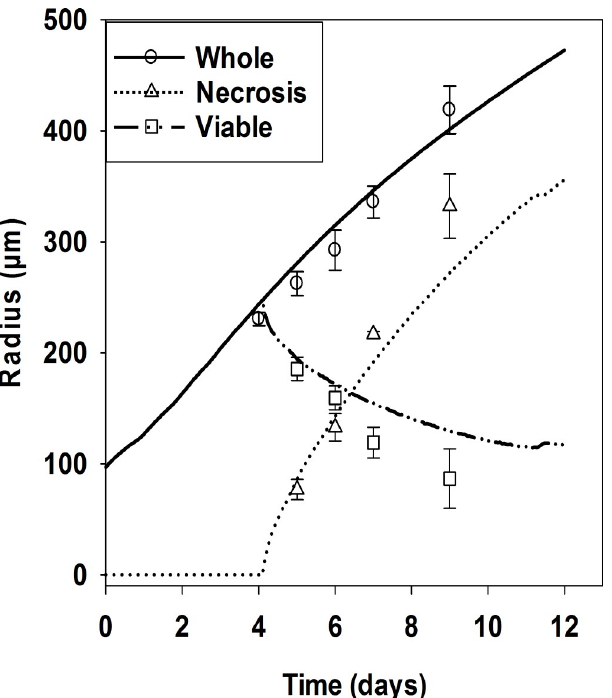
Fig 4. Quantitation of histological characteristics of spheroids and comparison with outputs of the SABM. The overall diameter (circles), diameter of the necrotic region (triangle), and thickness of viable rim (plotted here as twice the viable rim thickness, rectangles) of HCT116 spheroids were quantitated using H&E stained histological sections illustrated in Fig 3. Values are means ± SD (n = 4 spheroids, 5 on day 7). The lines are the corresponding outputs of SABM simulations using oxygen and glucose parameters fitted to monolayer and MCL experimental data (See Table